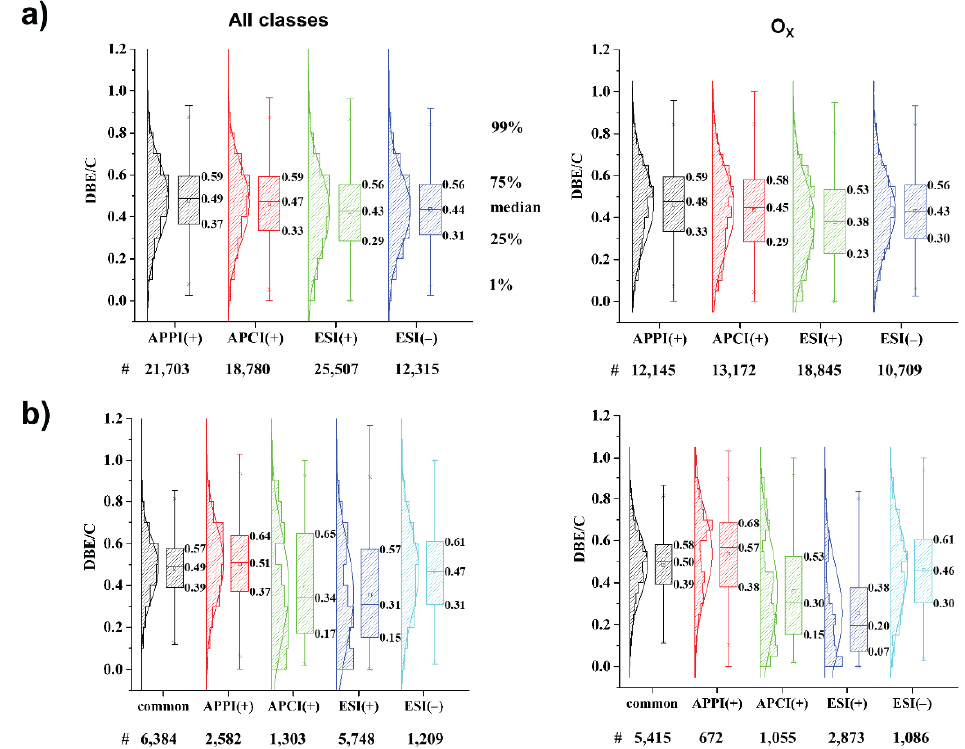
Figure 7. ( a ) DBE/C distribution of unique compositions for all heteroatom classes (left) and for O x only (right) for individual ionization methods. ( b ) DBE/C distribution for all heteroatom classes (left) and for O x only (right) for compositions assigned commonly to all ionization methods and for compositions uniquely found with each method.